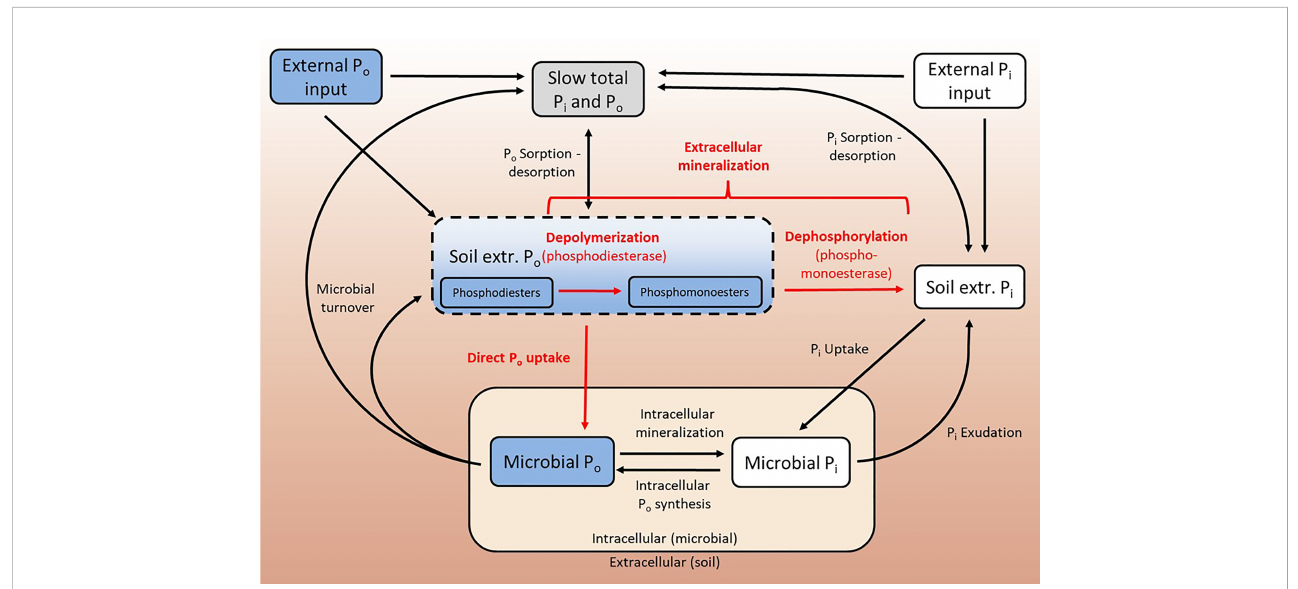
FIGURE 1 Schematic representation of soil P cycle processes. Bio-available P o is mineralized extracellularly, where phosphodiesters are depolymerized by phosphodiesterases, yielding smaller phosphomonoesters. Phosphomonoesters can be dephosphorylated by phosphomonoesterases, and the resulting bio-available P i can be taken up by the microbial community. In microbes, P o compounds are synthesized and mineralized. P i can be exuded by microbes, and P o is mainly released into soil via microbial turnover. Soil P i (and P o ) are subject to sorption and desorption processes. The current paradigm is that bio-available P o cannot be directly taken up by soil microbes. Fluxes in red are in the focus of this